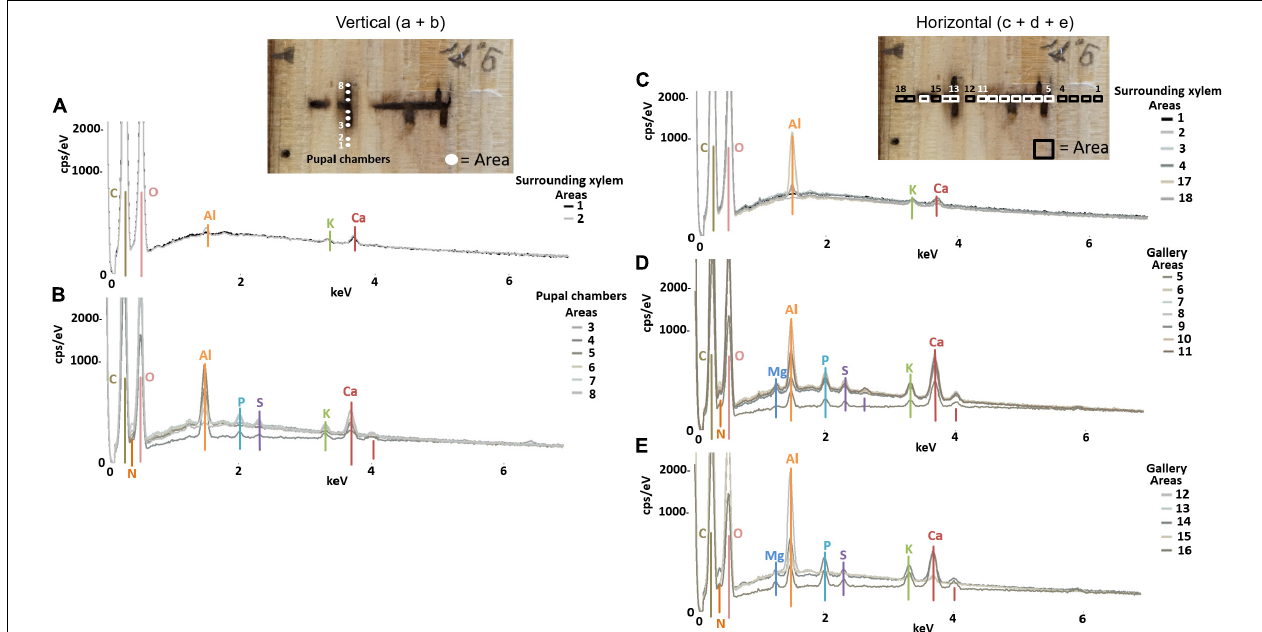
FIGURE 3 | Elemental composition of gallery walls, pupal chambers and xylem surrounding a gallery of Trypodendron lineatum (ID = T.lin9) using SEM-EDX. Pupal chambers were examined in vertical (A,B) direction, while the gallery was examined in horizontal (C–E) direction, respective to wood grain; location and numbers of measured areas are given in the photos on top. The Y -axis of each plot is counts per second (cps) per electronvolt (eV) of each element, while the X -axis is the applied electricity in kilo-electronvolt (keV).